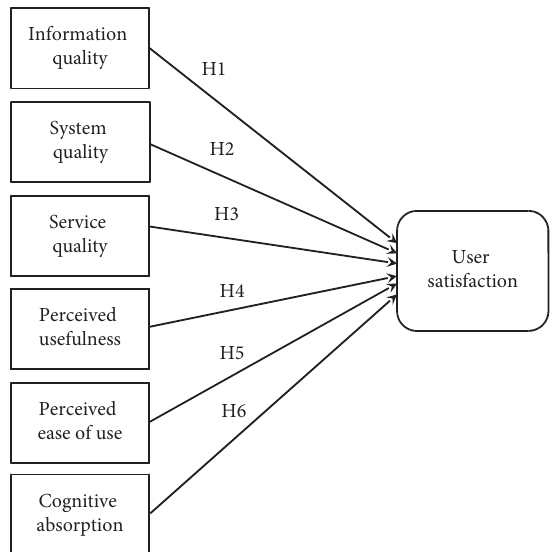
Figure 1: Users’ satisfaction with digital libraries